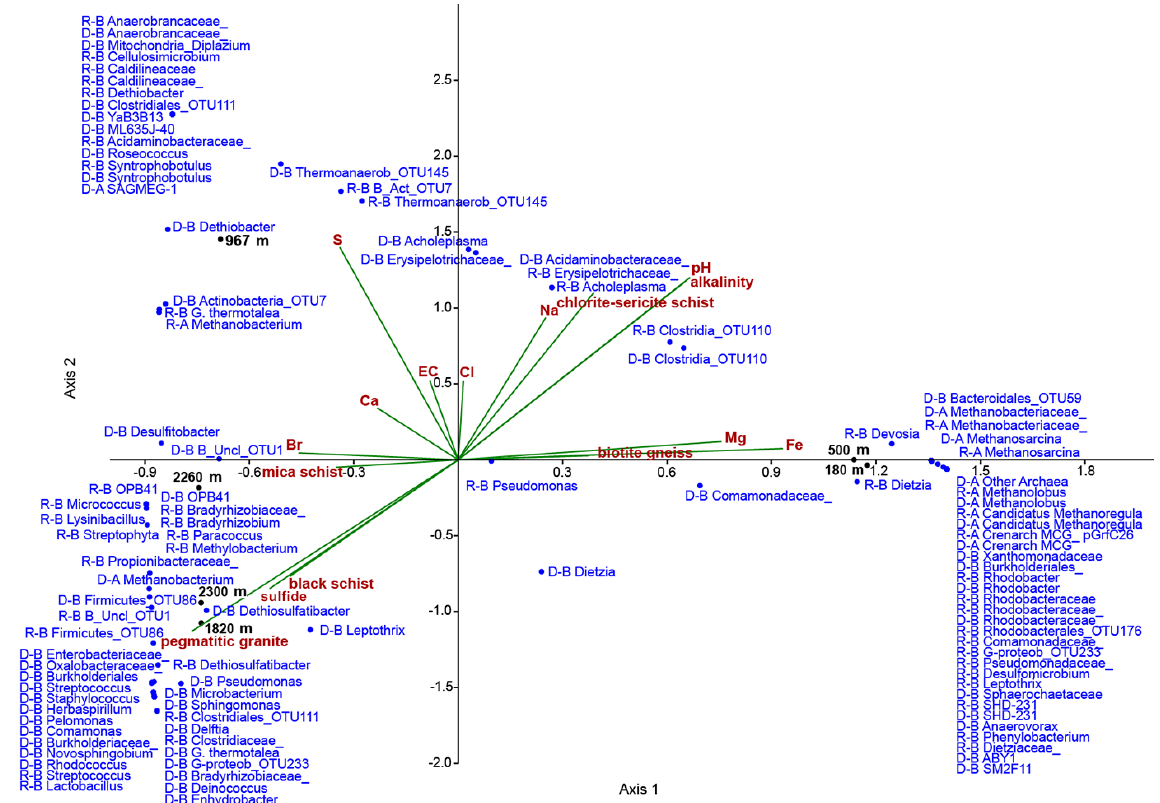
Figure 3. Canonical correspondence plot of the microbial OTUs (blue, with letters before the OTU name denoting the origin and the domain, i.e. D: derived from DNA; R: derived from RNA; B: bacteria; A: archaea), depths (black) and the geochemical parameters (red). The horizontal axis explains the 35% of the variance of the data with statistical significance ( p <0.01), while the vertical axis explains 27% of the variance of the data ( p =